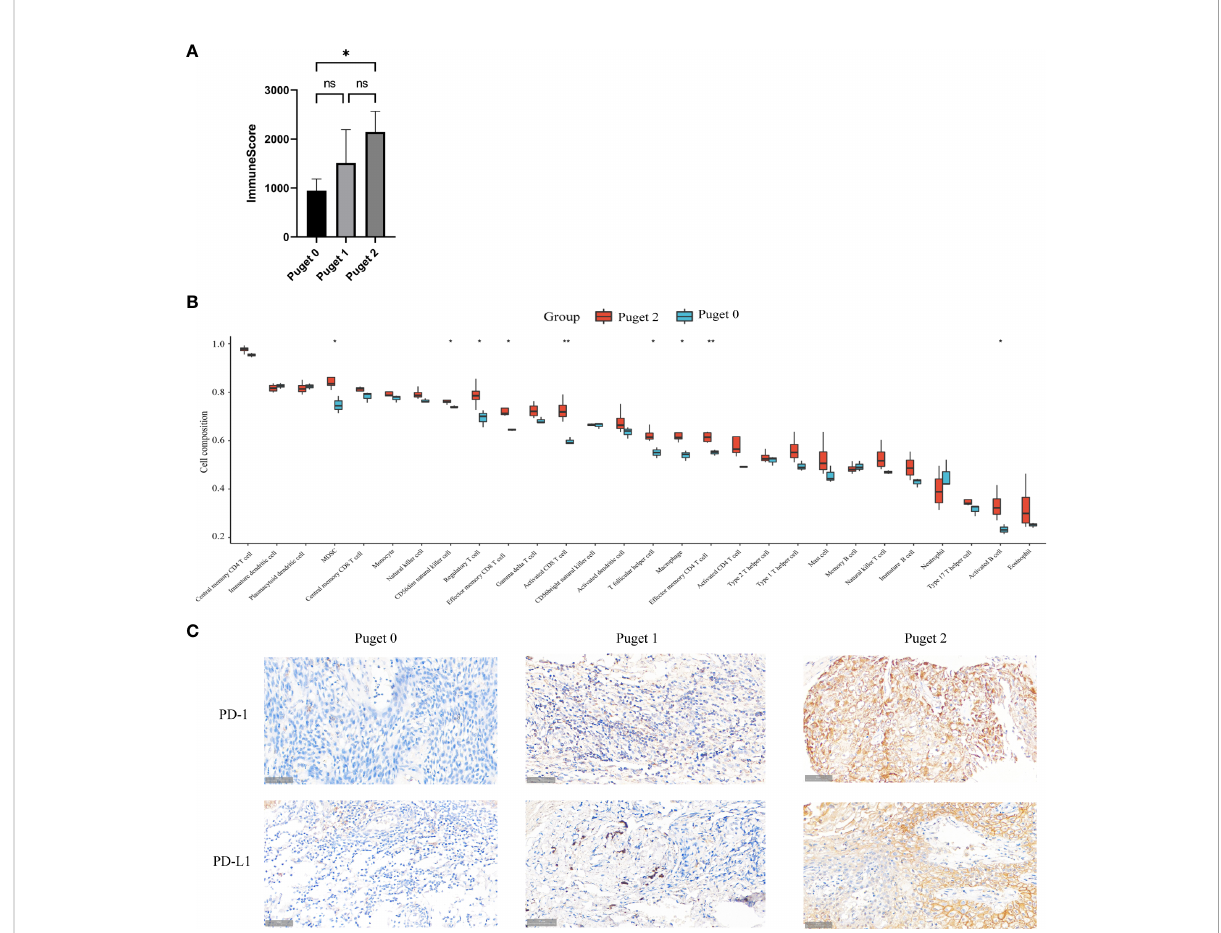
FIGURE 3 Aggressive PCPs have particular immune microenvironment. (A) . Three groups (Puget grade 0, n = 3; Puget grade 1, n = 4; Puget grade 2, n = 4) were analyzed using immune scores. ns: p > 0.05; *: p ≤ 0.05. (B) Twenty-eight subtypes of tumor-in fi ltrating immune cells in high aggressive groups (Puget grade 2, n = 4) compared with those in low aggressive groups (Puget grade 0, n = 3). The following symbols indicate statistical signi fi cance: blank: p > 0.05; * p ≤ 0.05; **p ≤ 0.01. (C) . IHC staining of PD-1 and PD-L1 in high aggressive PCP tissues compared to low aggressive PCP tissues,